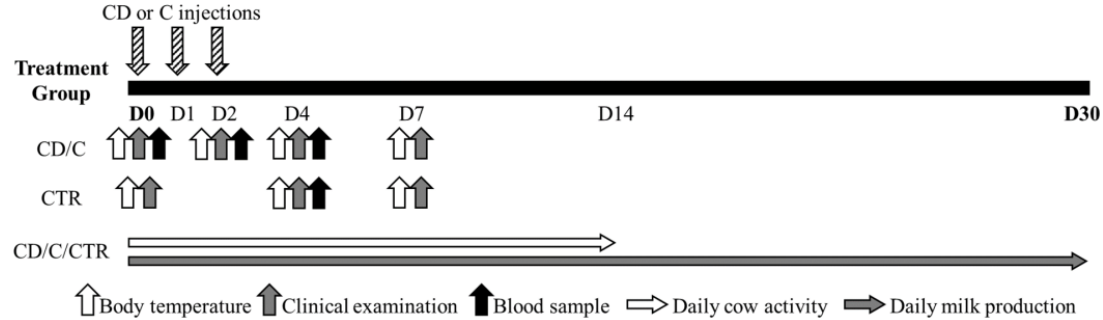
Figure 1. Cow monitoring protocol during the first 30 days (D) of the study period (CD = ceftiofur + ketoprofen; C = ceftiofur; CTR = control).